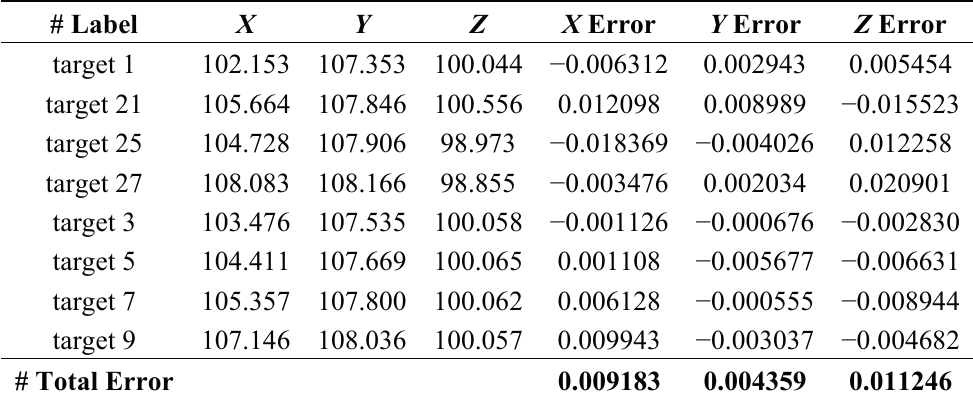
Table 5. Zenithal undistorted strip errors.